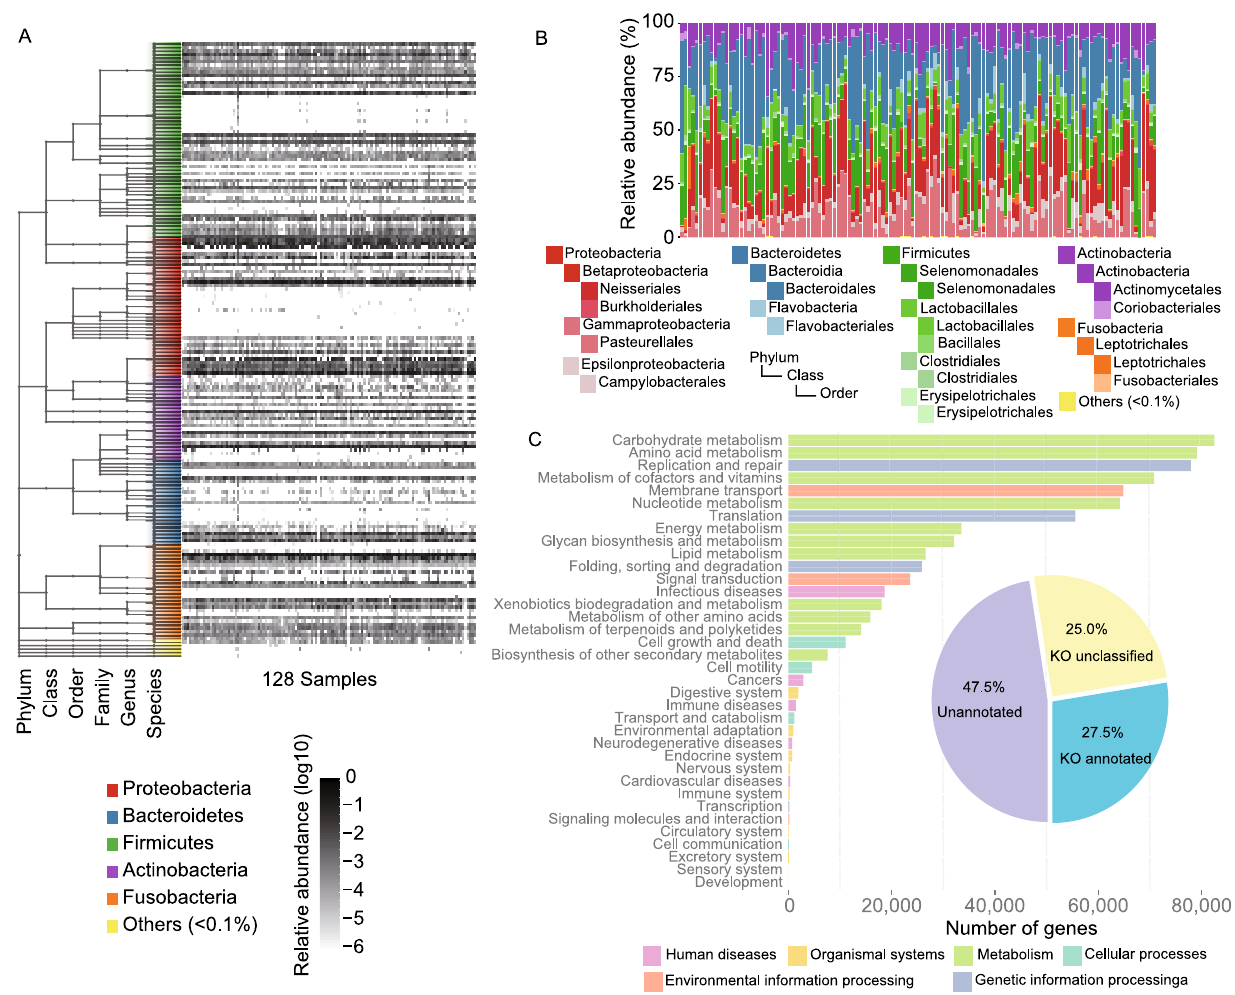
Figure 2. Taxonomy and gene pro fi les of the tongue-coating samples. (A) The relative abundance of species identi fi ed in tongue-coating samples, ordered by the taxonomy tree. (B) Relative abundance of major phyla across tongue-coating samples. (C) Gene counts annotated to different